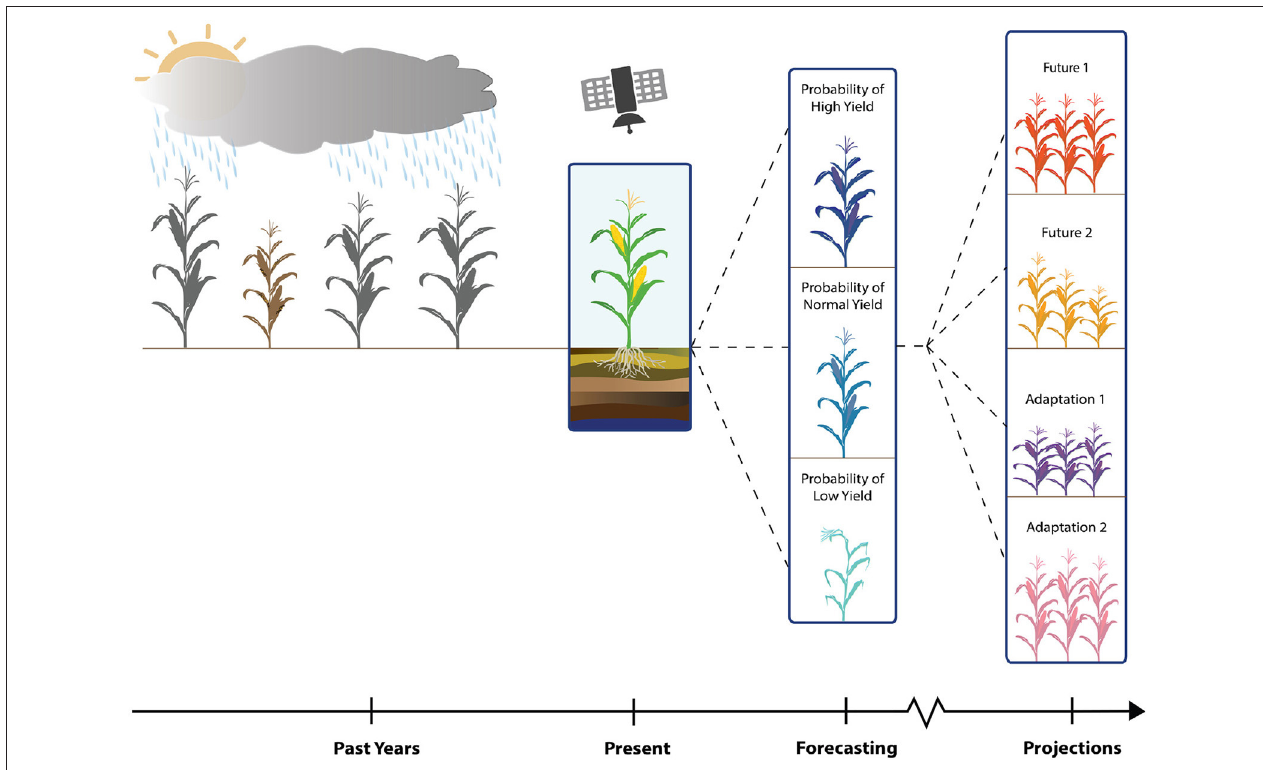
FIGURE 1 | Retrospective, real-time, forecast, and projection modes for agricultural applications. Resources include weather observations, satellites, and crop model projections. The focus is on understanding historical anomalies, providing detail on current state, providing probabilistic forecasts, and projecting alternate scenarios affected by factors within and beyond the farming